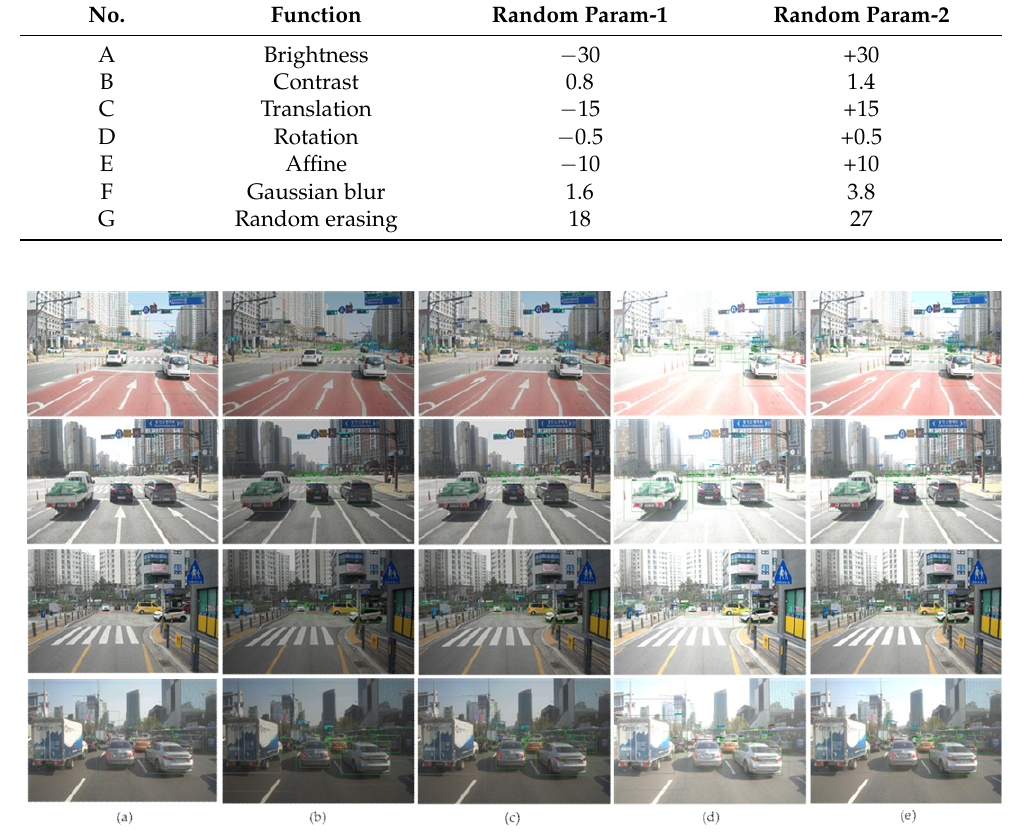
Figure 12. Augmentation brightness factor control example: ( a ) original image, ( b ) − 30% brightness, ( c ) −15% brightness, ( d ) +30% brightness, and ( e ) +15% brightness.